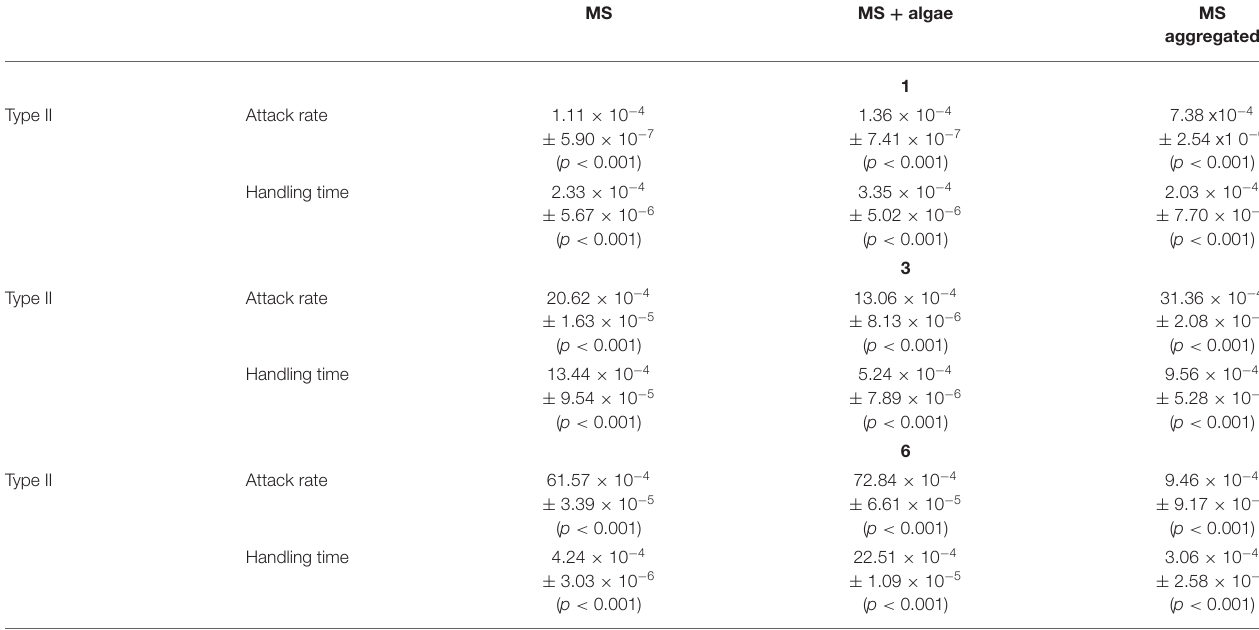
TABLE 4 | Parameter estimates from type II (see Equation 1 in the text) functional responses for three sizes of MS (1, 3, and 6) and the treatments (MS, MS + algae, MS aggregated). MS MS + algae MS